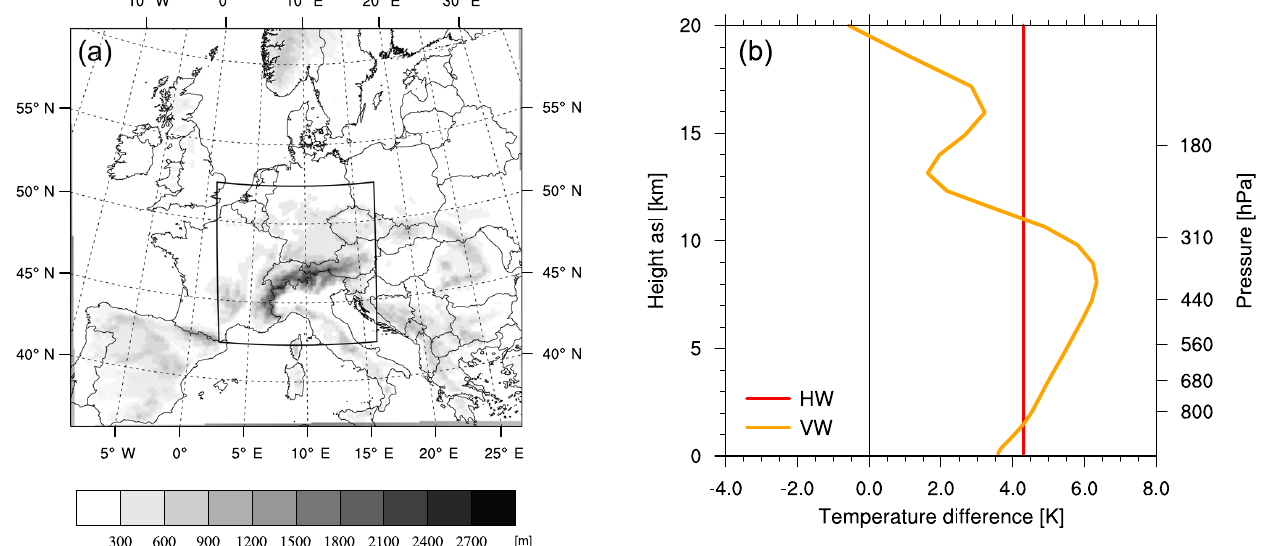
Figure 1. (a) Computational domains of the convection-parameterizing simulations (CPM, full domain, 12km resolution) and convection- resolving simulations (CRM, box in the center, 2km resolution). Topography (m) is indicated in gray shading. The inner box also corresponds to the analysis domain. (b) Height profiles of the temperature differences for homogeneous warming (HW) and vertically dependent warming (VW) relative to the control at the lateral boundaries of the CPM simulation domain, averaged over the investigated period (taken from Kröner et al., 2017). Height is indicated in kilometers on the left-hand side, and pressure values at particular heights, averaged over the 11-day period, are indicated in hPa on the right-hand